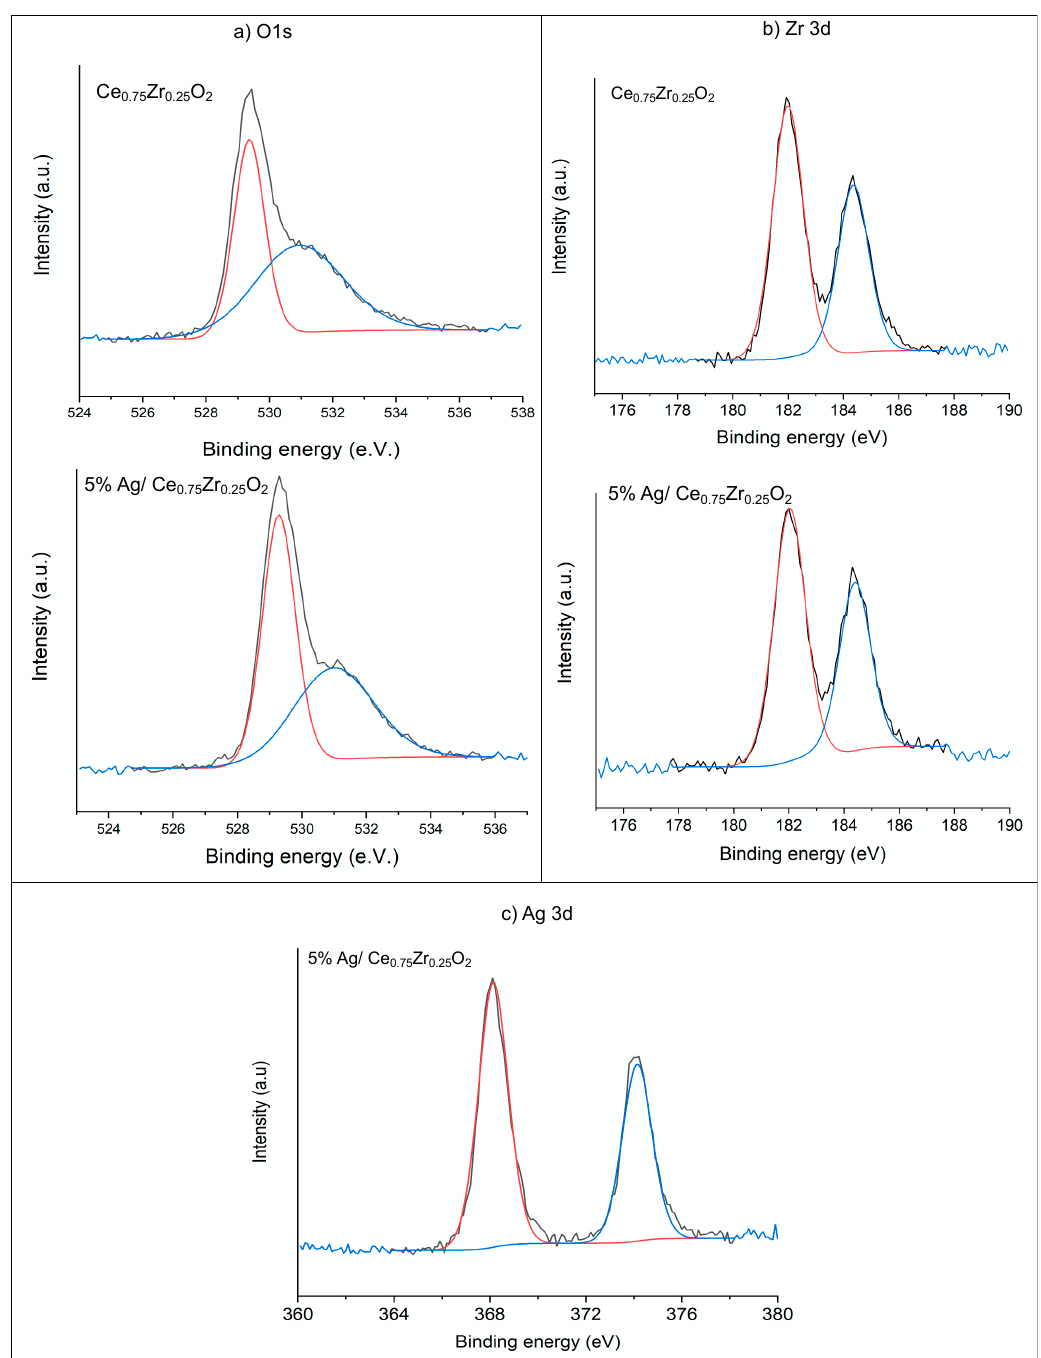
Figure 4. XPS spectra of Ce 0.75 Zr 0.25 O 2 support and 5%Ag/Ce 0.75 Zr 0.25 O 2 catalyst for ( a ) O 1s peaks, ( b ) Zr 3d peaks, and ( c ) Ag 3d